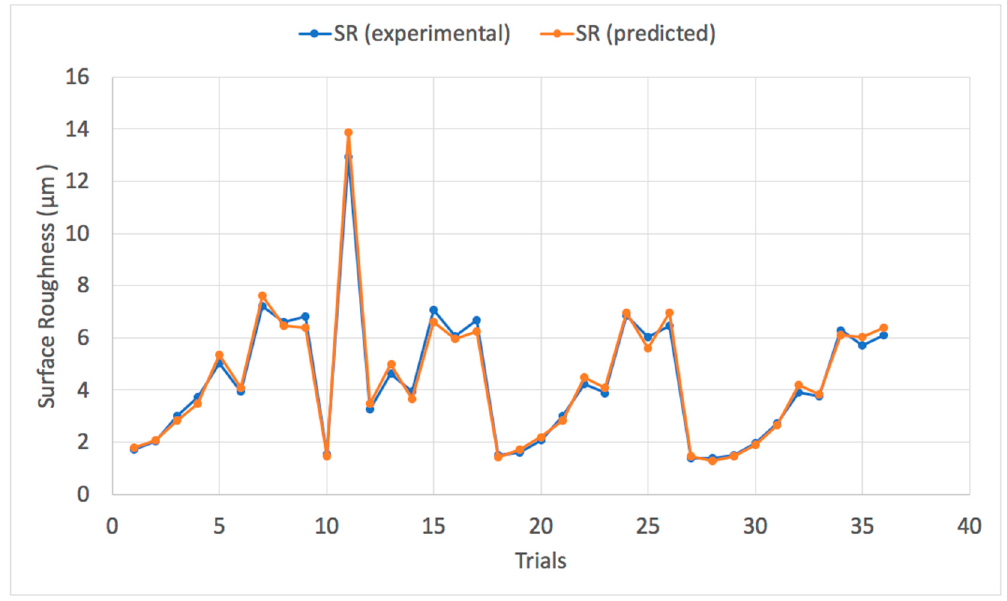
Figure 12. Experimental surface roughness vs. predicted surface roughness values of a cryogenic turning process using ANFIS-QPSO.